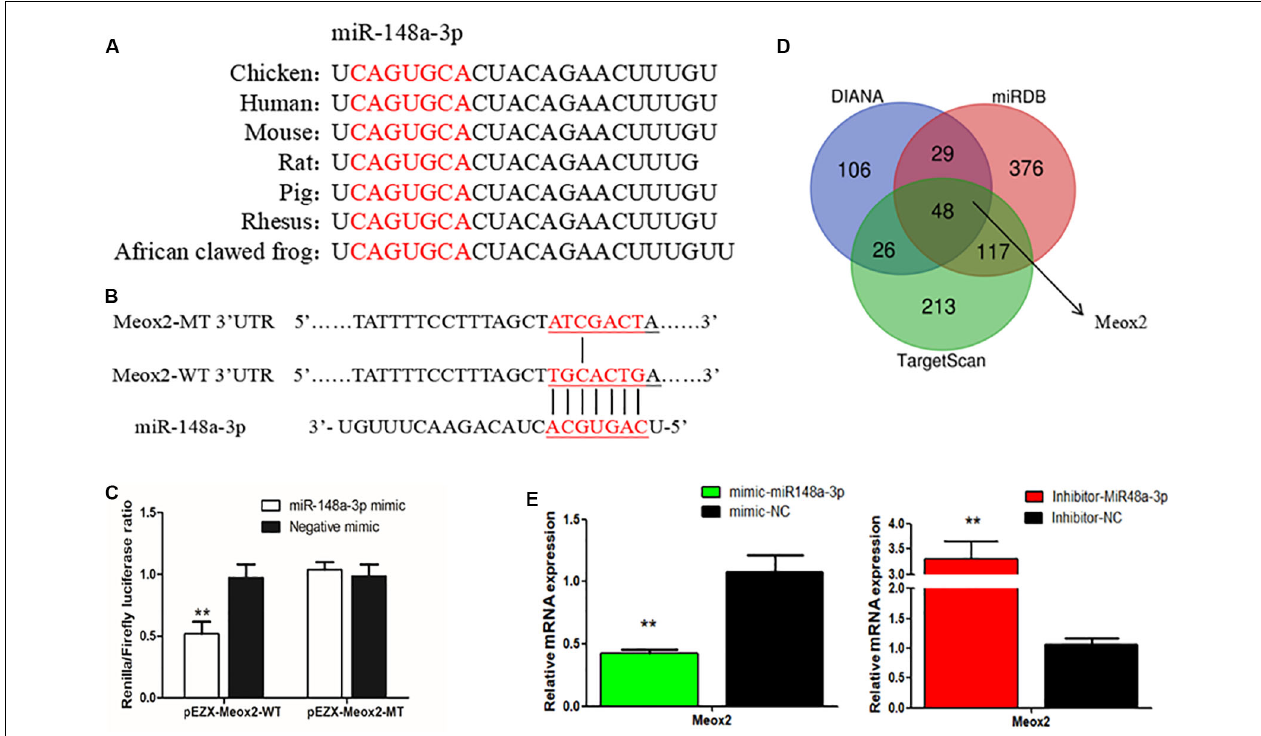
FIGURE 6 | Meox2 as a target gene of miR-148a-3p. (A) Seed sequence of miR-148a-3p. (B) Prediction of target genes using TargetScan, miRDB, and Diana. (C) Dual-luciferase reporter gene (pEZX-FR02) with wild type (pEZX-Meox2-WT) or mutant (pEZX-Meox2-MT). (D) Luciferase assays were performed by co-transfection of wild-type or mutant Meox2 3 (cid:48) UTR with a miR-148a-3p mimic or mimic-NC in SMSCs. (E) Expression of Meox2 following transfection with miR-148-30 by use of qRT-PCR. Data are expressed as mean ± SEM ( N = 3). ** P < 0.01 vs.